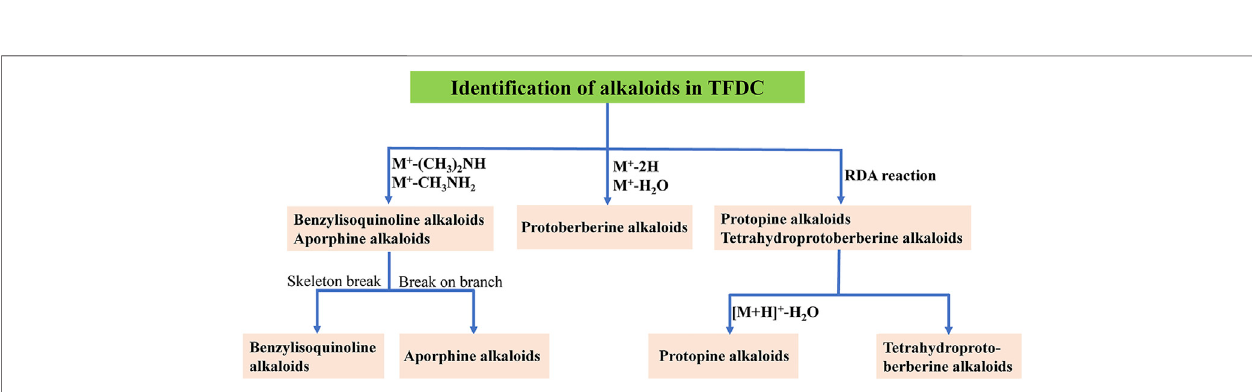
Frontiers in Pharmacology |